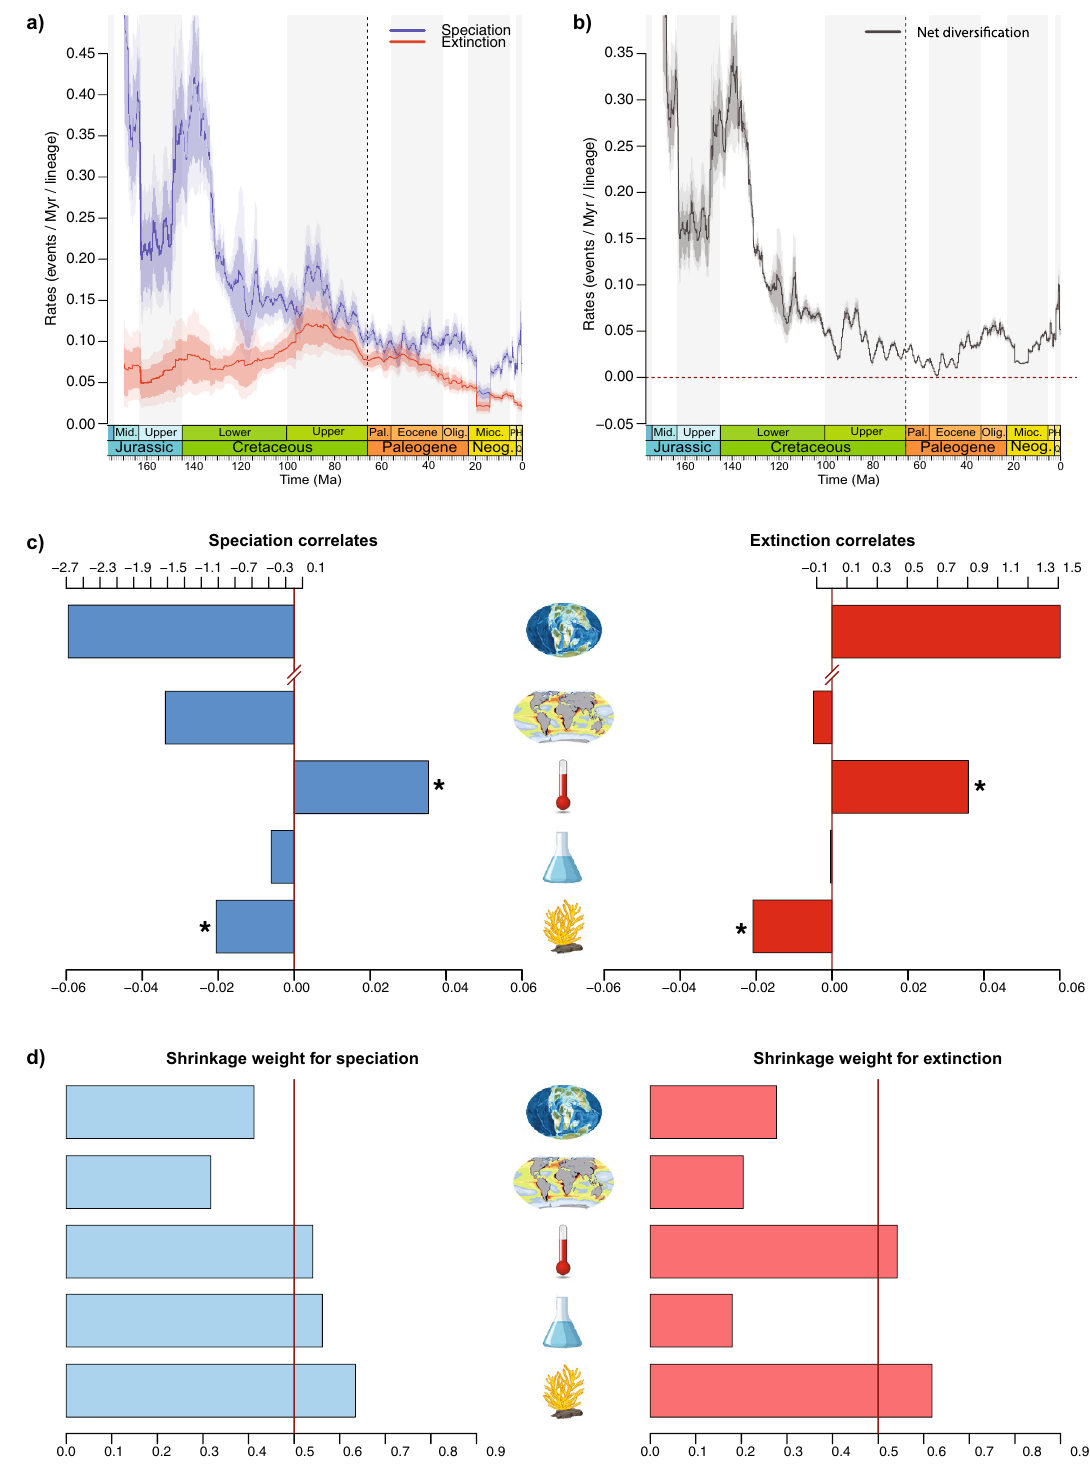
Figure 8. Dynamics of rates through time estimated with the Bayesian Multivariate Birth–Death model. Using the combined palaeontological and neontological data, we incorporated the effect of five environmental factors over speciation and extinction ( a ), and net diversification ( b ) for carcharhiniform species. Solid lines indicate mean posterior rates and shaded areas show 95% HPD. The contribution of each environmental variable to the dynamics of rates through time is represented by Bayesian inferences of correlation parameters on speciation (blue bars) and extinction (red bars) with the tested environmental parameters ( c ) and shrinkage weights ( d ). Highly significant correlations are represented by an asterisk and ω > 0.5 (red vertical bar). For details on the estimations of parameter correlates, see Supplementary Data S18. In panels ( c ) and ( d ), icons represent the five environmental variables, which are from top to bottom: continental fragmentation (index), oceanic productivity (δ13C in ‰), temperature (in °C), sea level (in metres), and biological reef volume (in km 3 ). In panel ( c ), the upper axis refers to correlates for the continental fragmentation index, whereas the lower axis refers to all other variables, due to scale